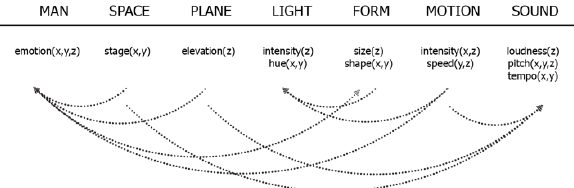
Figure 2 | Mapping Plutchik’s emotions three-dimensional space model (x,y,z) to the ToT variables, and cross-modal feedback. Source: